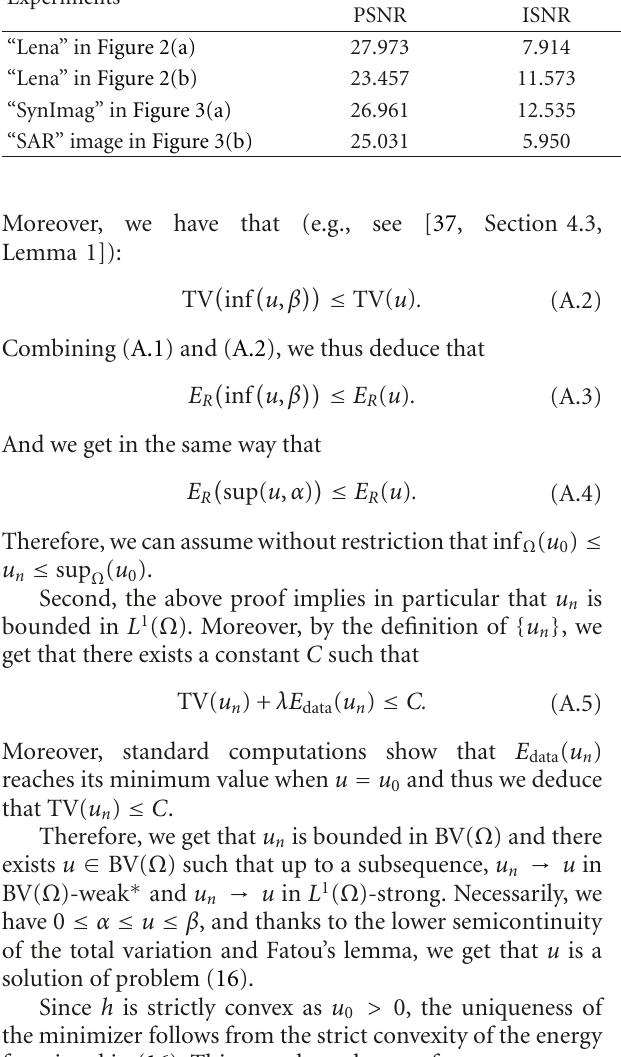
Table 4: The PSNR, ISNR, and ReErr of the restored images using two di ff erent initial guesses in our algorithms.